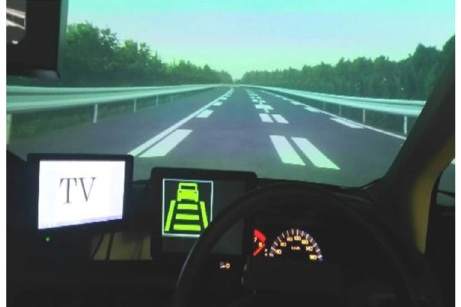
Figure 2 View from the driver's seat of the driving